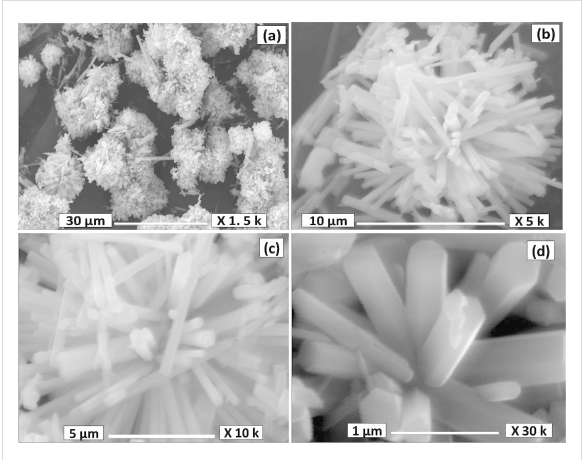
Figure 4: Low and high magnification SEM micrographs of h-MoO 3